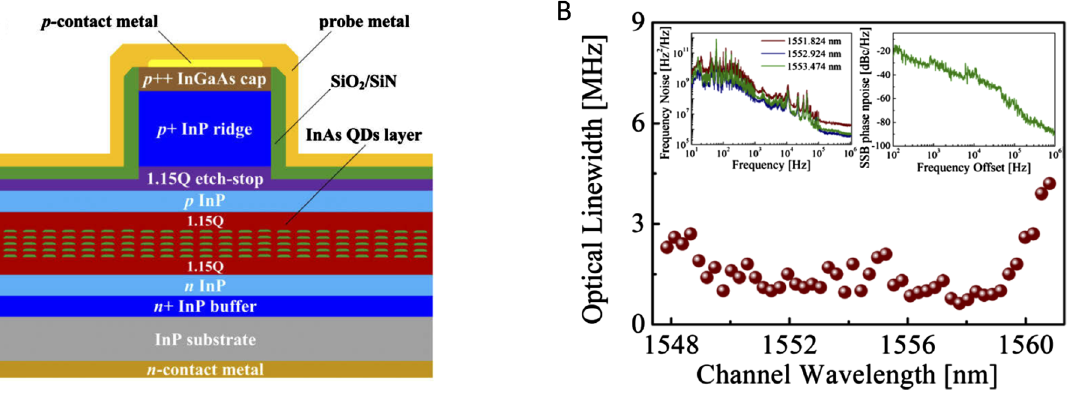
Figure 5: A passively mode-locked InAs/InP quantum dash laser. (A)Schematicofthecrosssection.(B)Opticallinewidthoffilteredindividualcomblines.(Leftinset)frequencynoisespectrafromthreefiltered comb lines at the wavelengths of 1551.824, 1552.924 and 1553.474 nm (Right inset) Single sideband (SSB) phase noise of the RF beating. Reprinted with the permission from Ref. [30], Copyright 2020, Optical Society of